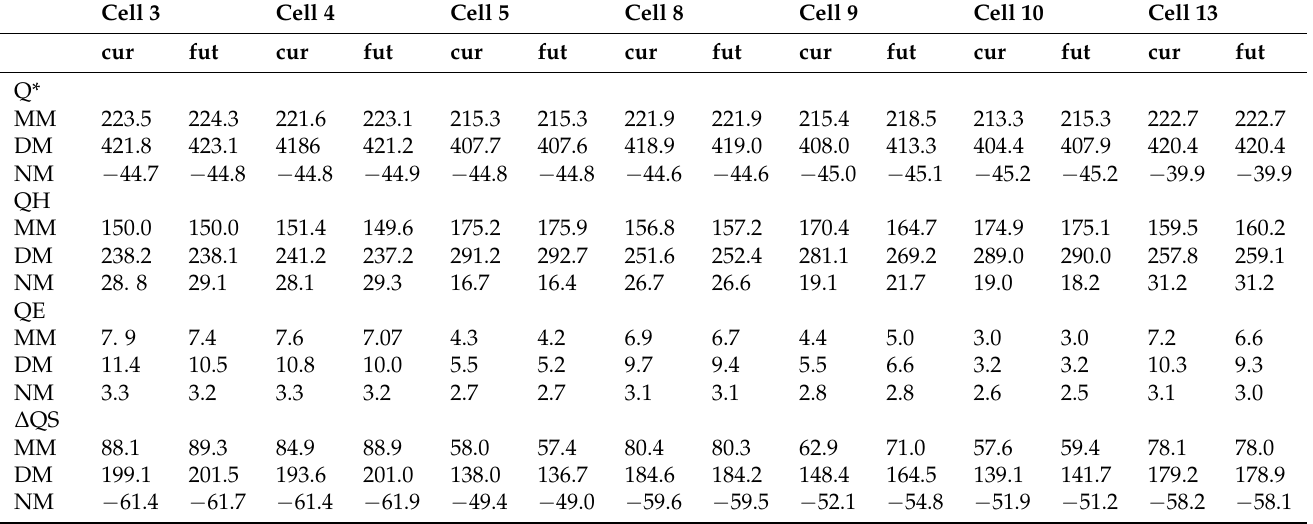
Table 6. Model outputs of the current and future runs per grid cell for Net All-Wave Radiation